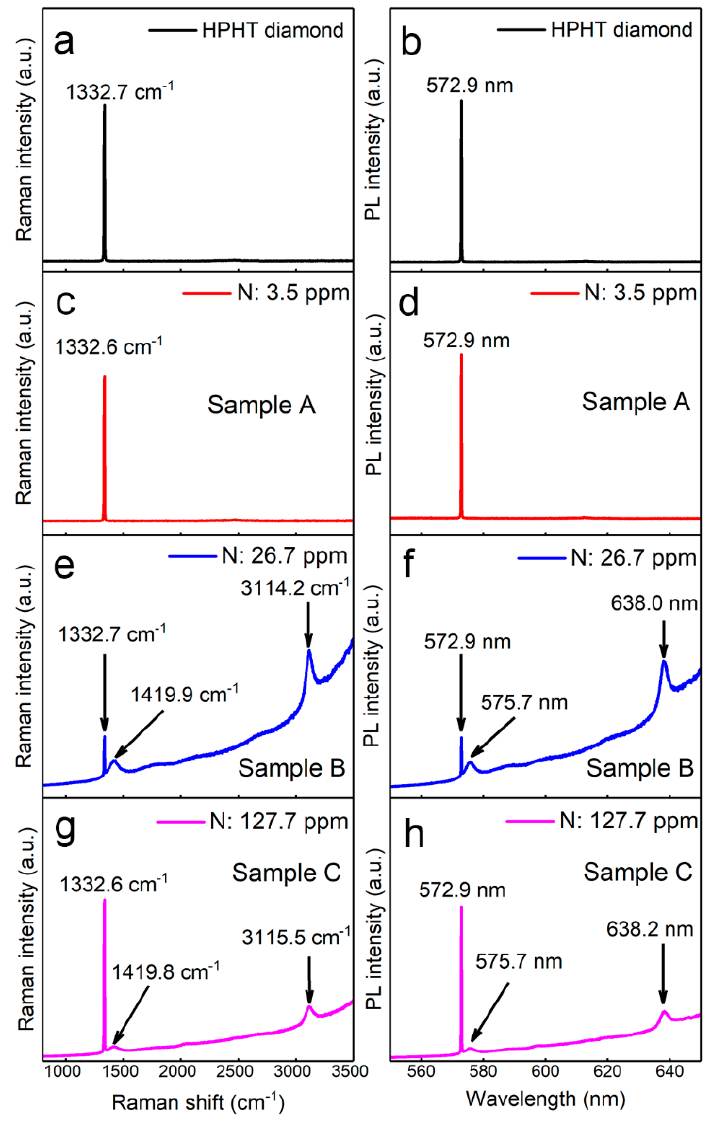
Figure 1. Raman and photoluminescence (PL) spectra of diamond samples in room temperature: ( a , b ) high pressure high temperature (HPHT) diamond and epitaxial chemical vapor deposition (CVD) diamond with nitrogen concentrations of ( c , d ) 3.5 ppm, ( e , f ) 26.7 ppm and ( g , h ) 127.7 ppm.